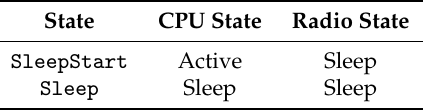
Table 6. States in a Sleep